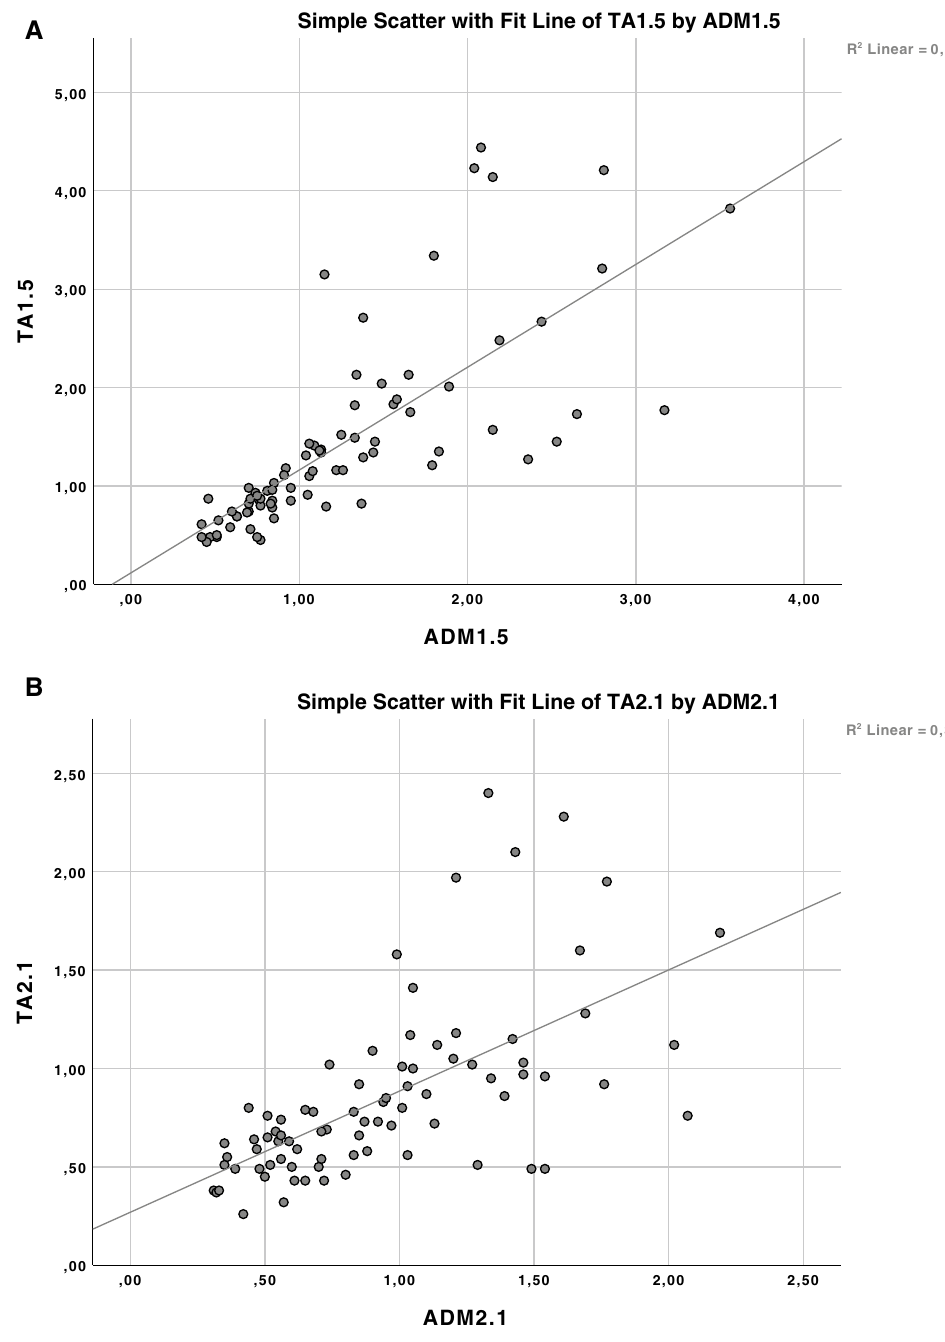
Figure 2. Similarity of short-interval intracortical inhibition and facilitation between the abductor digiti minimi (ADM) and tibialis anterior (TA) representations. The similarity of the inhibitory and facilitatory interactions in all 81 cells of the matrix defined by the 9 × 9 intensity conditions of the first and second stimulus in the paired-pulse TMS protocol was compared for the ADM and TA at the interstimulus intervals of 1.5 ms ( A ) and 2.1 ms ( B ) by linear regression statistics. In the regression plots, values < 1.0 indicate short-interval intracortical inhibition, and values > 1.0 short-interval intracortical facilitation. Note that the high correlation coefficients of r = 0.752 ( A ) and r = 0.626 ( B ) provide strong evidence that the null hypothesis that the inhibitory and facilitatory interactions for the two muscle representations are regulated independently can be rejected (both p <